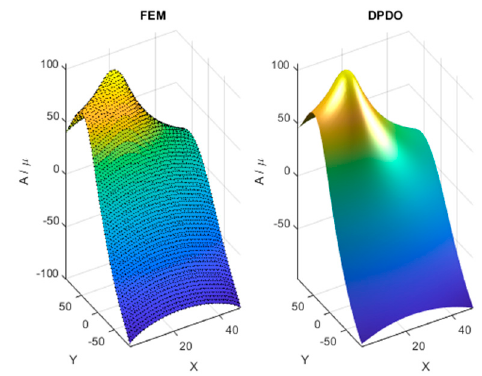
Figure 9. Magnetic potential A ( x , y ) / µ in the air window obtained using the Finite Element Method (FEM) and Discrete Partial Differential Operators (DPDO).